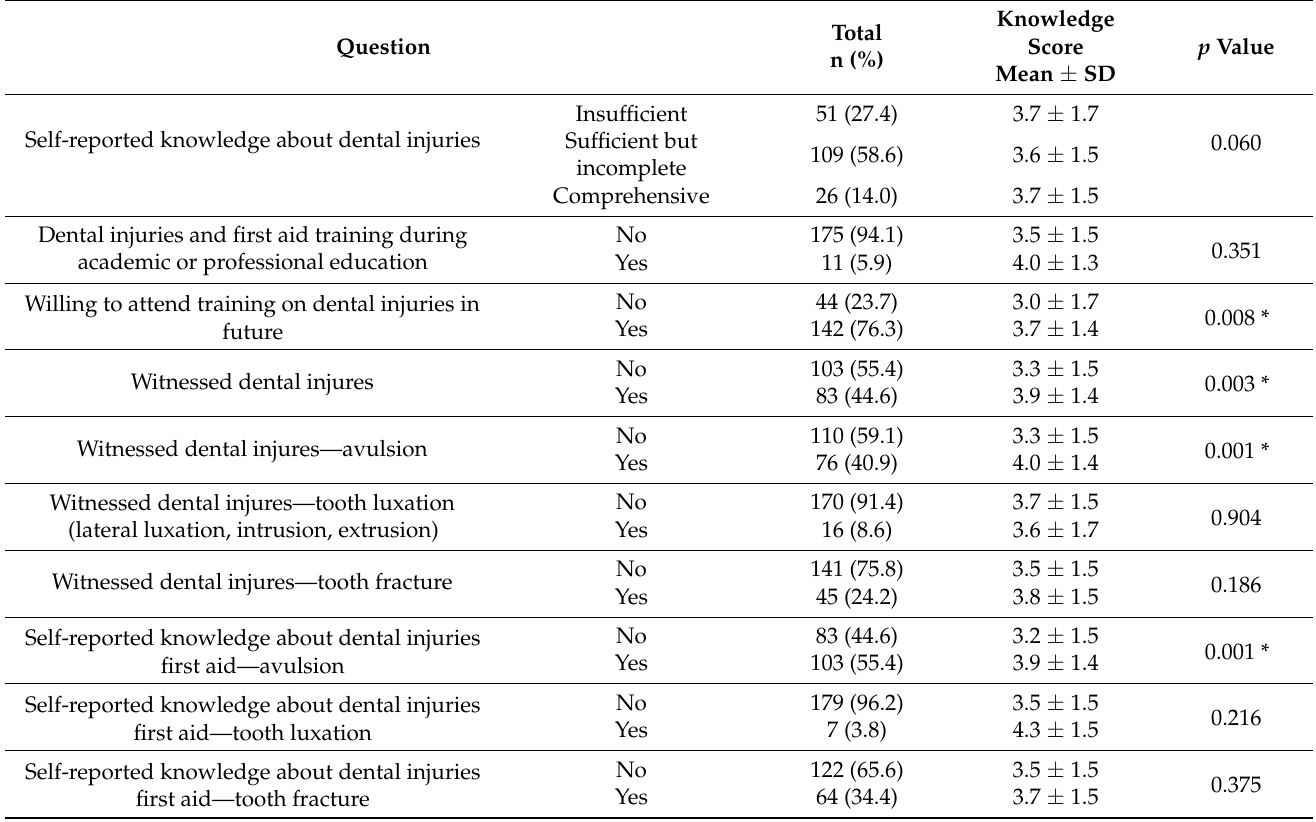
Table 3. Pediatrician’s knowledge and experience with dental injures (n = 186).